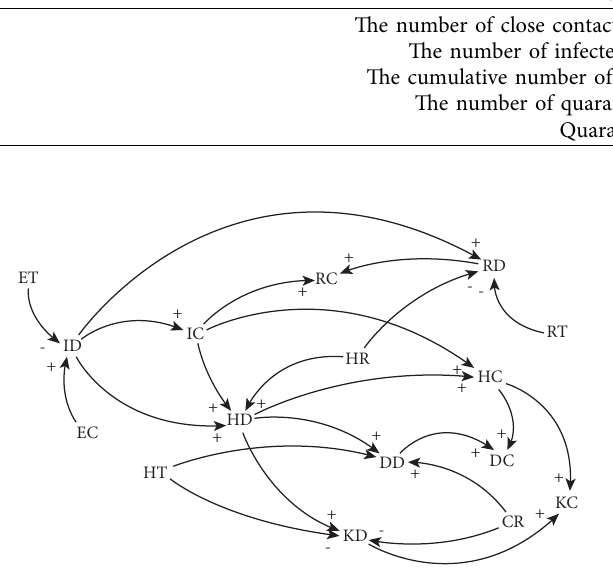
Figure 3: Causal relationship of the medical